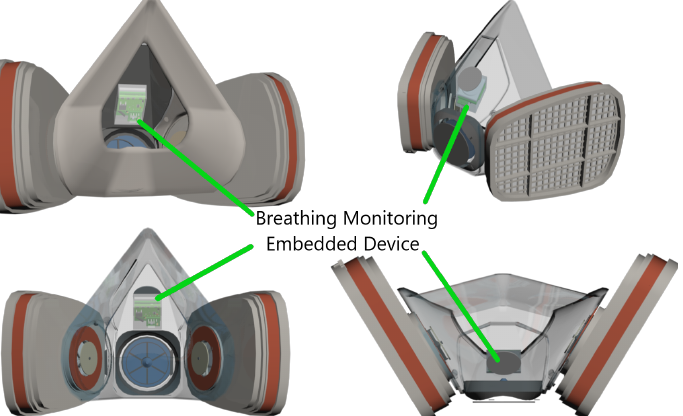
Figure 3. Isometric views of the reusable industrial respirator with the embedded electronic device magnetically attached using an external magnet.